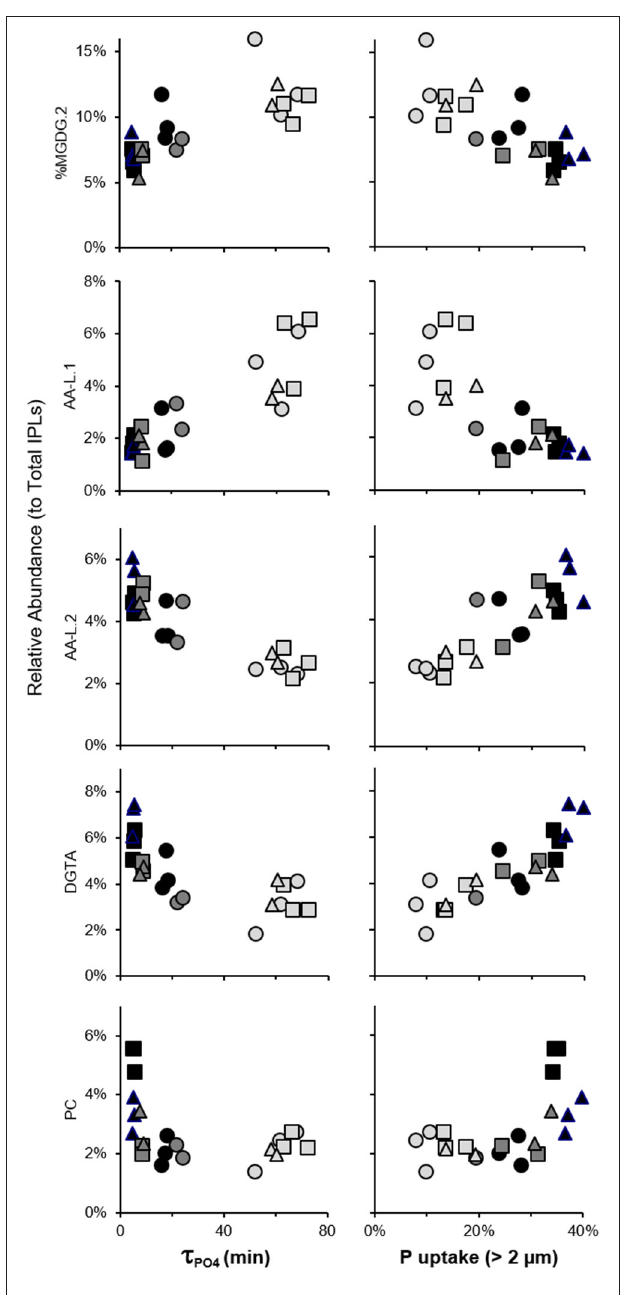
FIGURE 9 | Correlated changes in IPL relative abundance with τ PO4 and fractional phosphate uptake by plankton > 2 µ m in control mesocosms (circles) and those amended with Saharan dust (squares) or mixed aerosol (triangles) and collected on day − 1 (light gray), day 3 (dark gray), or day 6